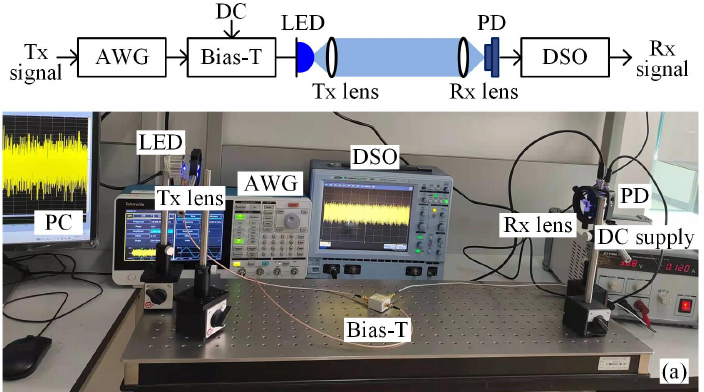
Figure 4. Experimental setup of a point-to-point VLC system using a blue mini-LED.